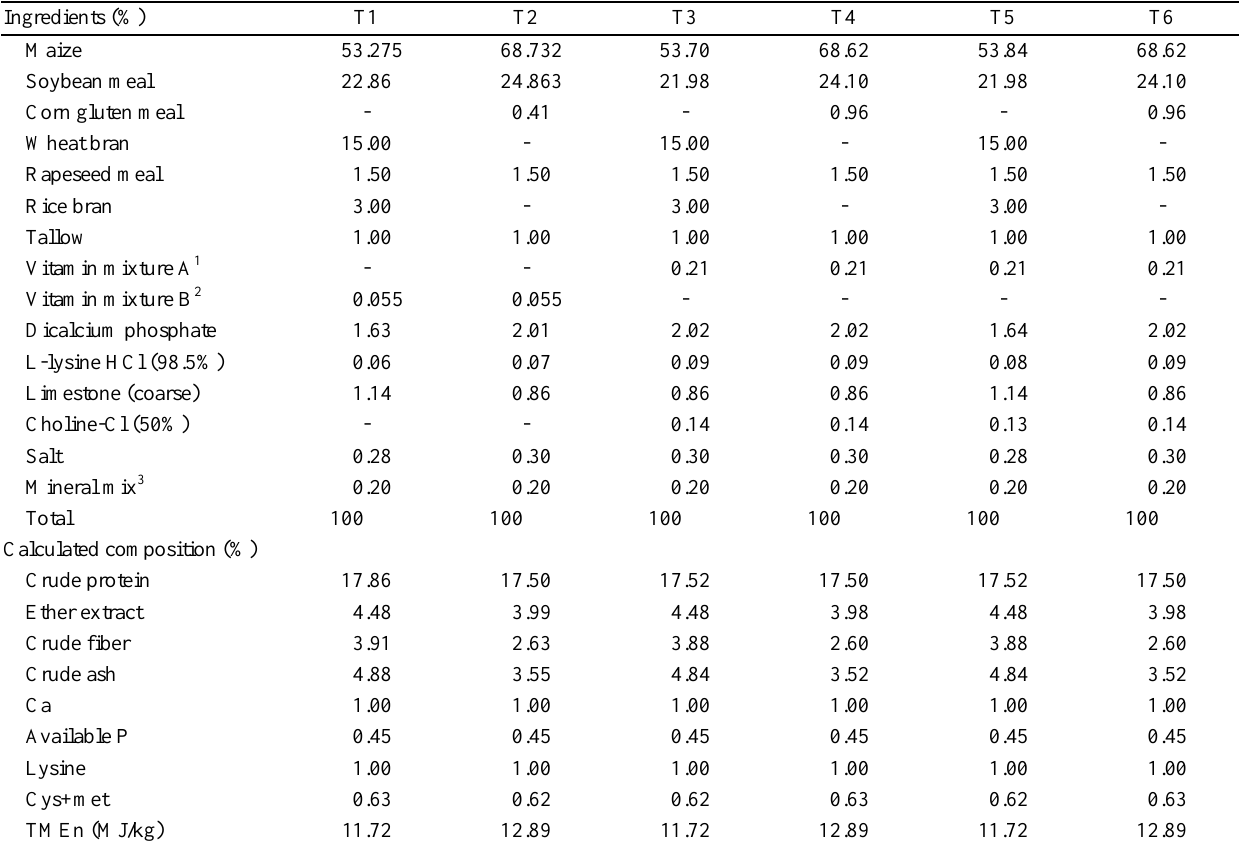
Table 1. The ingredients and chemical compositions of experimental diets Ingredients (%) Maize Soybean meal Wheat